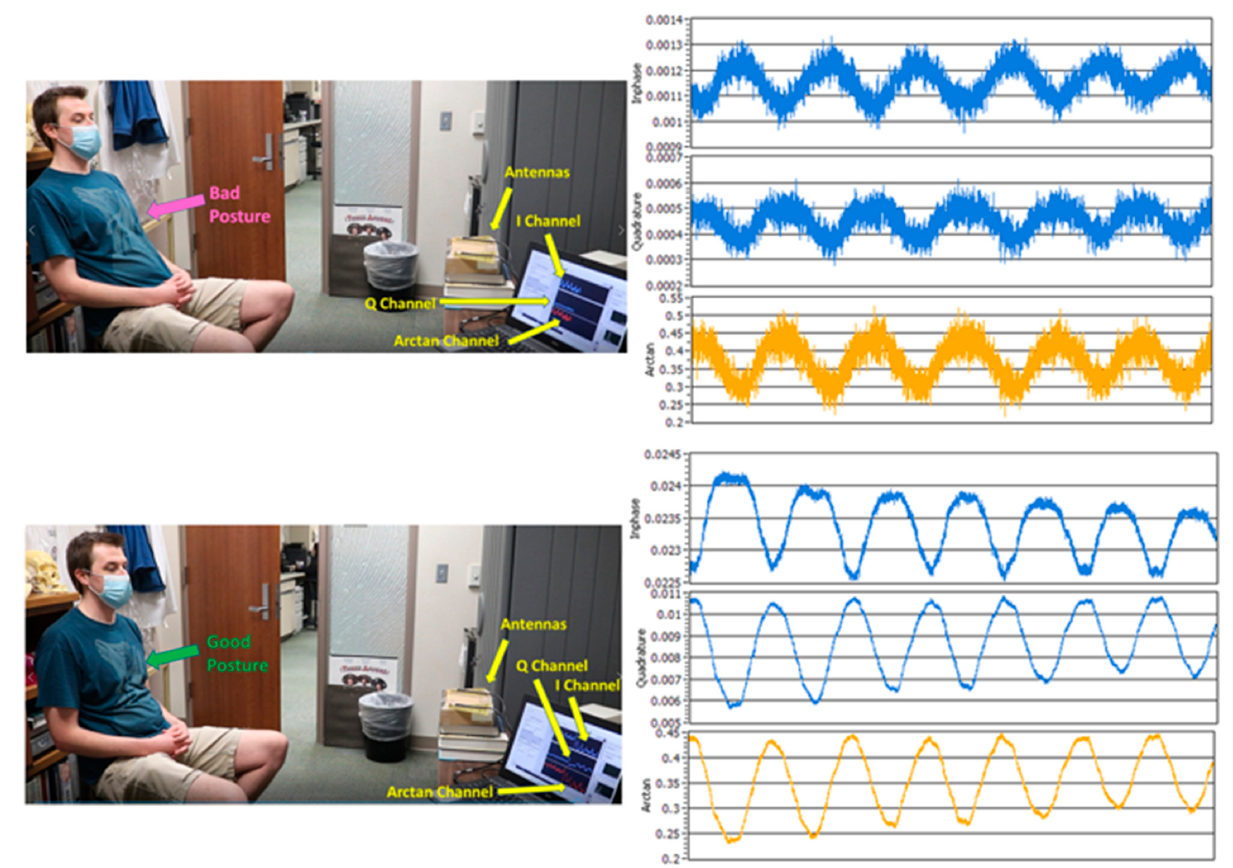
Figure 6. Plots showing a subject’s posture affects the quality of output waveforms for the NCVS sensor system and the vital signs monitoring accuracies.